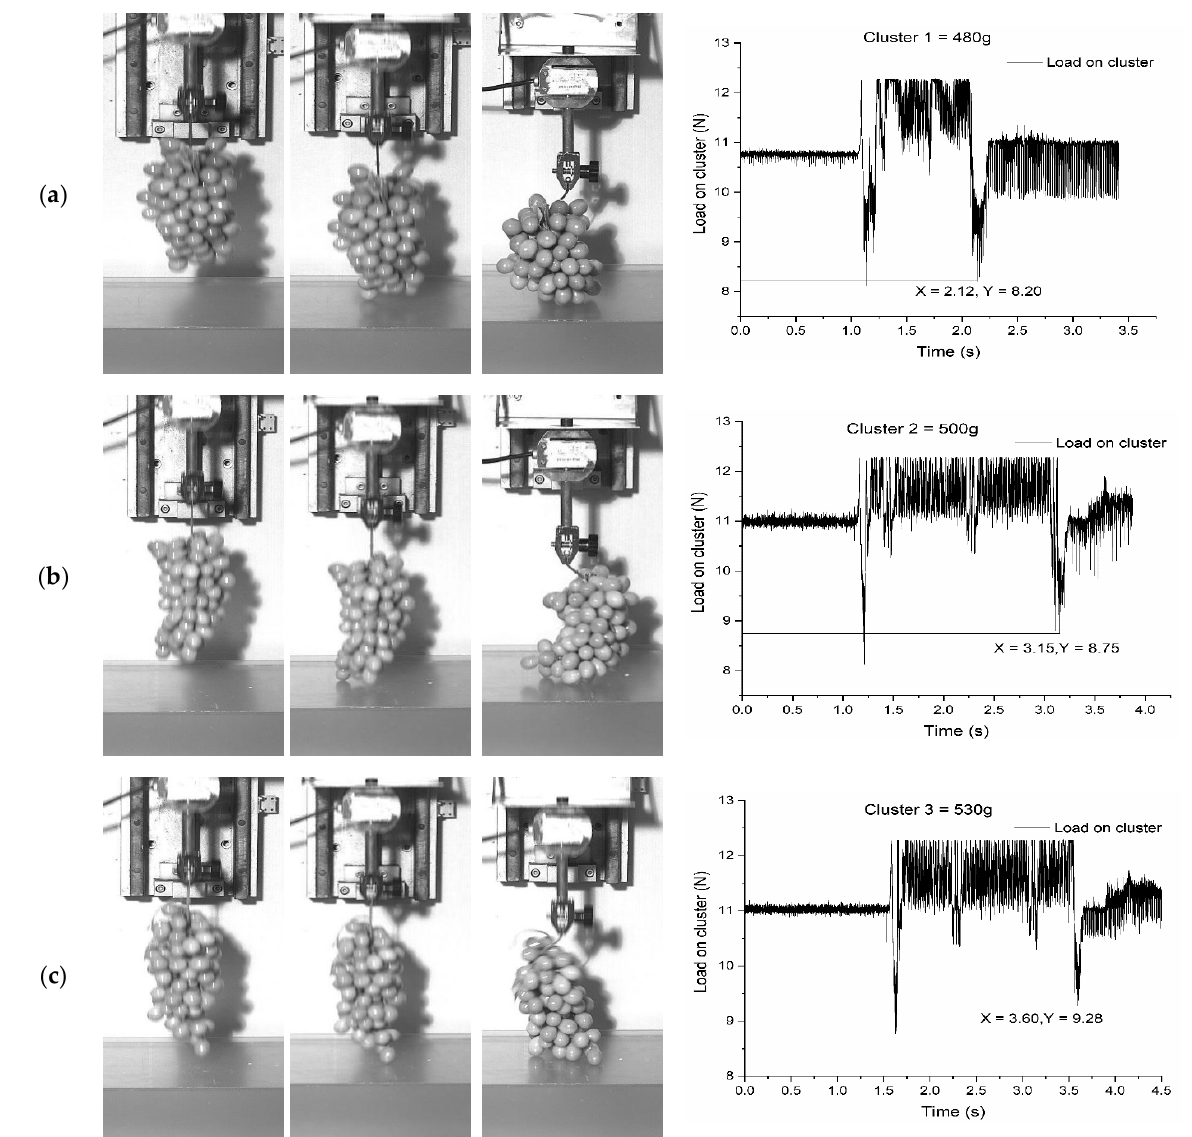
Figure 10. Effect of the cluster’s mass on force change during placing of grape clusters: ( a ) 480 g; ( b ) 500 g; ( c ) 530 g.